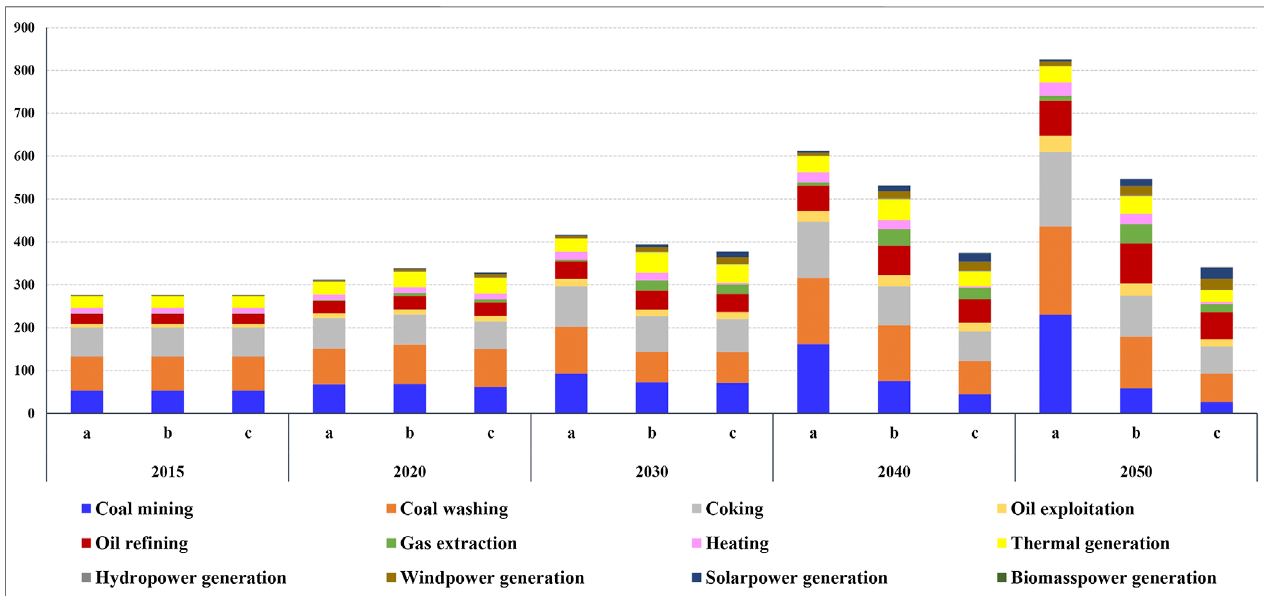
FIGURE 4 | The energy production of each sector in the three scenarios: (a) reference, (b) coordinated development scenario, (c) strong emission reduction (the detailed data was shown in Supplementary Table S7 ).